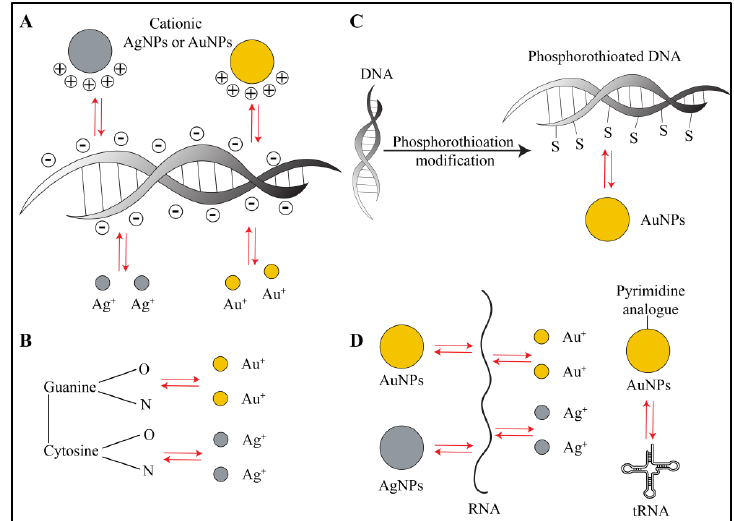
Figure 2. Schematic representation of interactions between biofilm nucleic acids and gold or silver nanoparticles. ( A ) Cationic gold nanoparticles, silver nanoparticles and their respective metal ions show electrostatic interactions, hydrophobic interactions and Van der Waals interactions with polyanionic eDNA in the biofilm. ( B ) The metal ions (Au + and Ag + ) in particular show a ffi nity towards G-C base pairs of eDNA, where they preferentially interact with oxygen and nitrogen atoms via short-range Van der Waals forces and hydrophobic forces. ( C ) In order to withstand oxidative damage, bacteria undergo phosphorothioation modification of DNA. Gold nanoparticles show highly specific gold–sulphur (Au-S) bonding interactions with such eDNA. ( D ) Both gold and silver nanoparticles and their ions show electrostatic interactions and Van der Waals interactions with bacterial RNA and tRNA. Red arrows in the figure indicate di ff erent types of